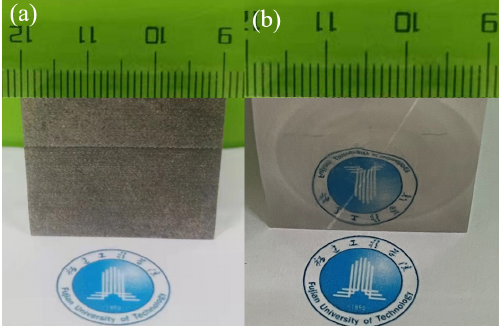
Figure 16. Comparison before and after polishing: (a) before and (b) after